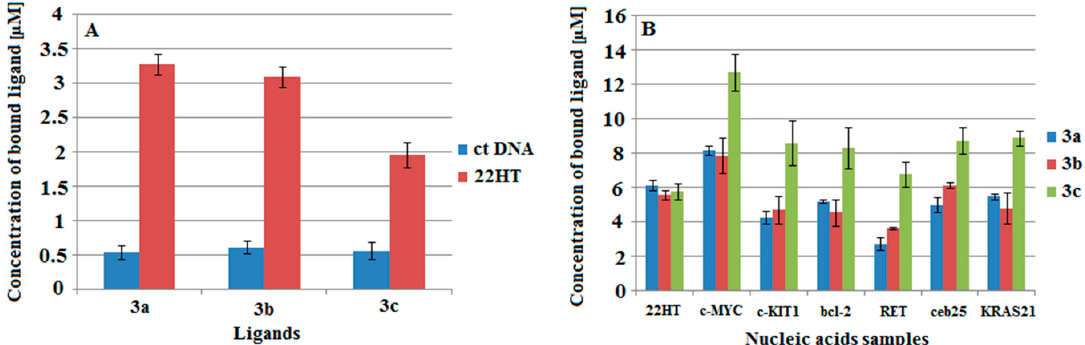
Figure 2. The effect of Triton X-100 on dissociation the ligand 3c (3 µM) from the DNA complex in